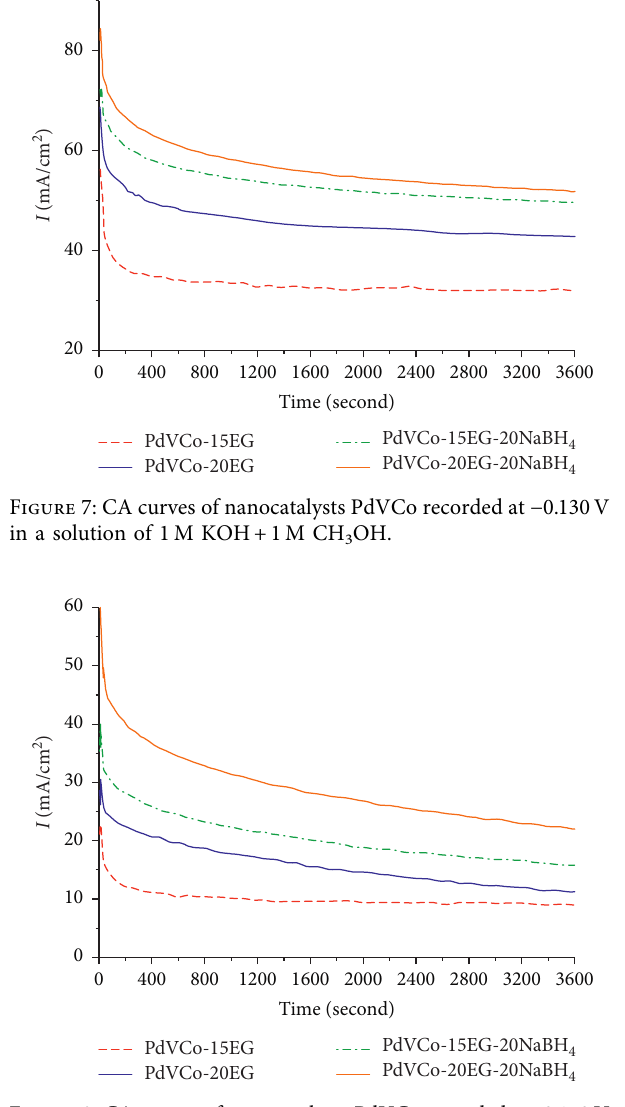
Figure 8: CA curves of nanocatalysts PdVCo recorded at -0.150V in a solution of 1 M KOH+1 M C 2 H 5